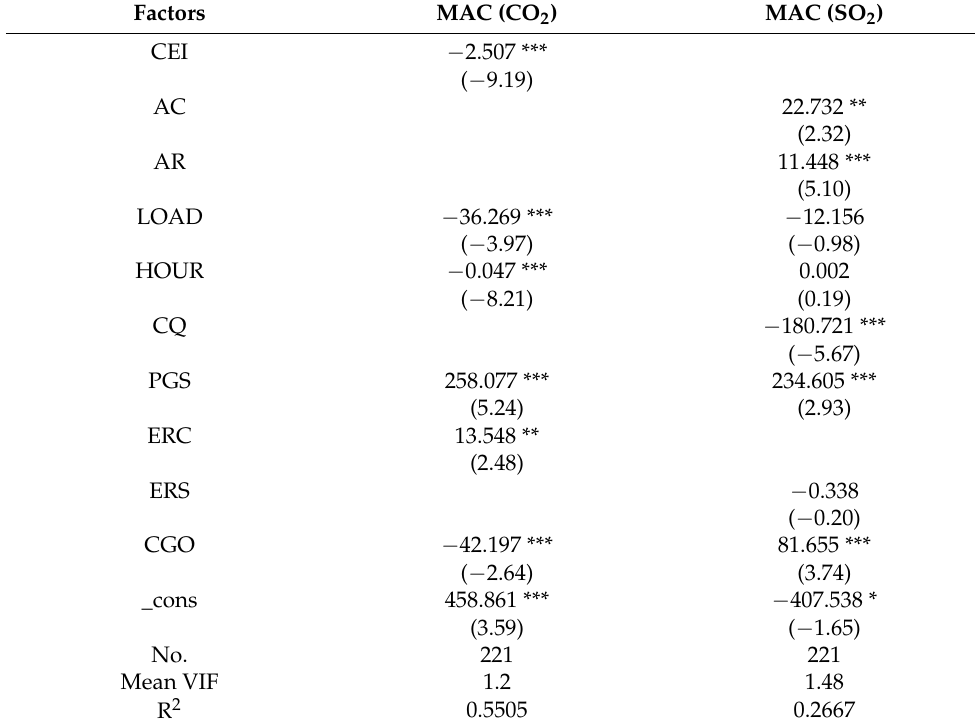
Table 4. Baseline regression